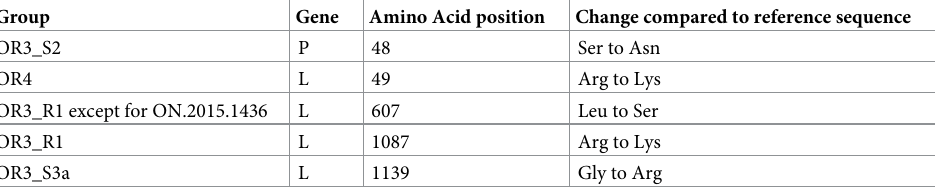
Table 1. Characteristics of five amino acid substitutions identified within the Hamilton RRV sample set.